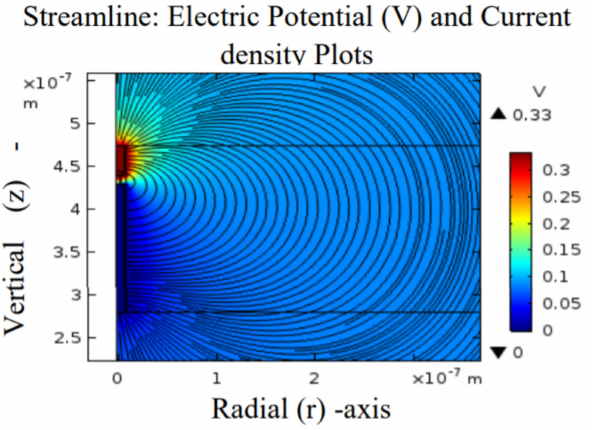
Figure 6. CF’s generated electric field. The generated electric field is due to the electrostatic charges formed by the radially developed CF.